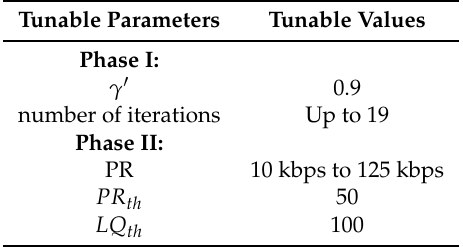
Table 4. Tunable parameters and their